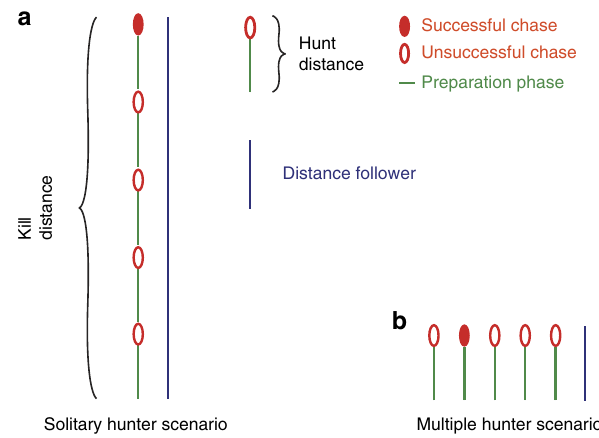
Figure 7 | Comparison of solitary versus group hunting scenarios. Solitary hunter ( a ) and multiple hunter ( b ) scenarios assuming a fictional individual kill rate of 0.2. On average, five hunts have to be conducted for one kill. Those hunts can be conducted consecutively by one hunter or simultaneously by five hunters. The kill distance is the sum of all hunt distances and is equal in both scenarios. However, costs (proportional to distance travelled) for individual hunters and for followers is lower for the multiple hunter scenario ( b